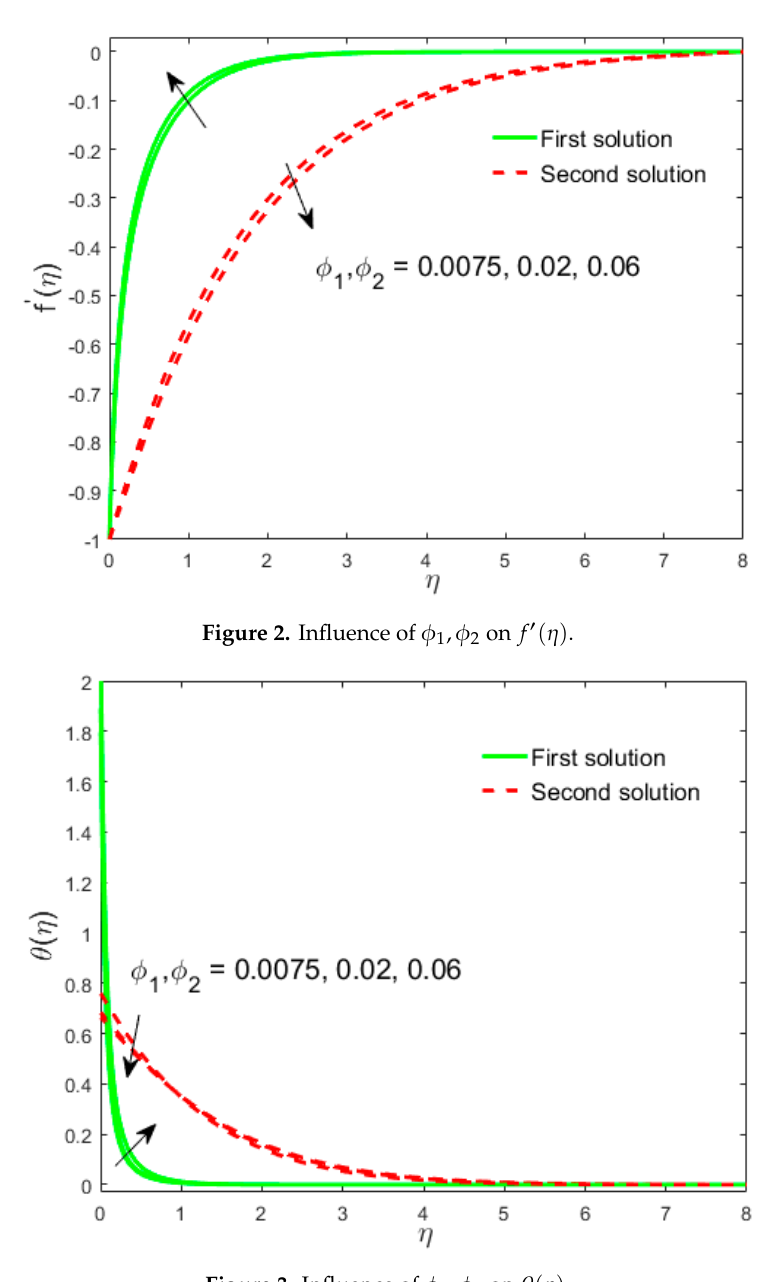
Figure 3. Influence of φ 1 , φ 2 on θ ( η )